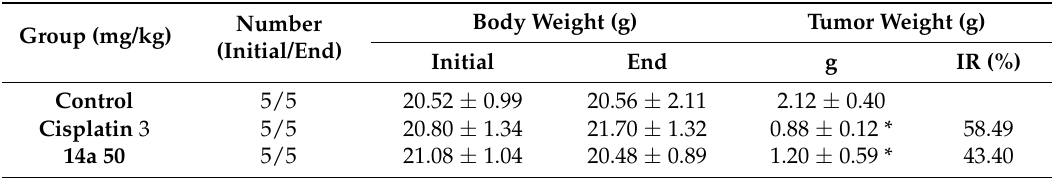
Table 2. The anti-tumor activity of 14a against the growth of Hela in nude mice a